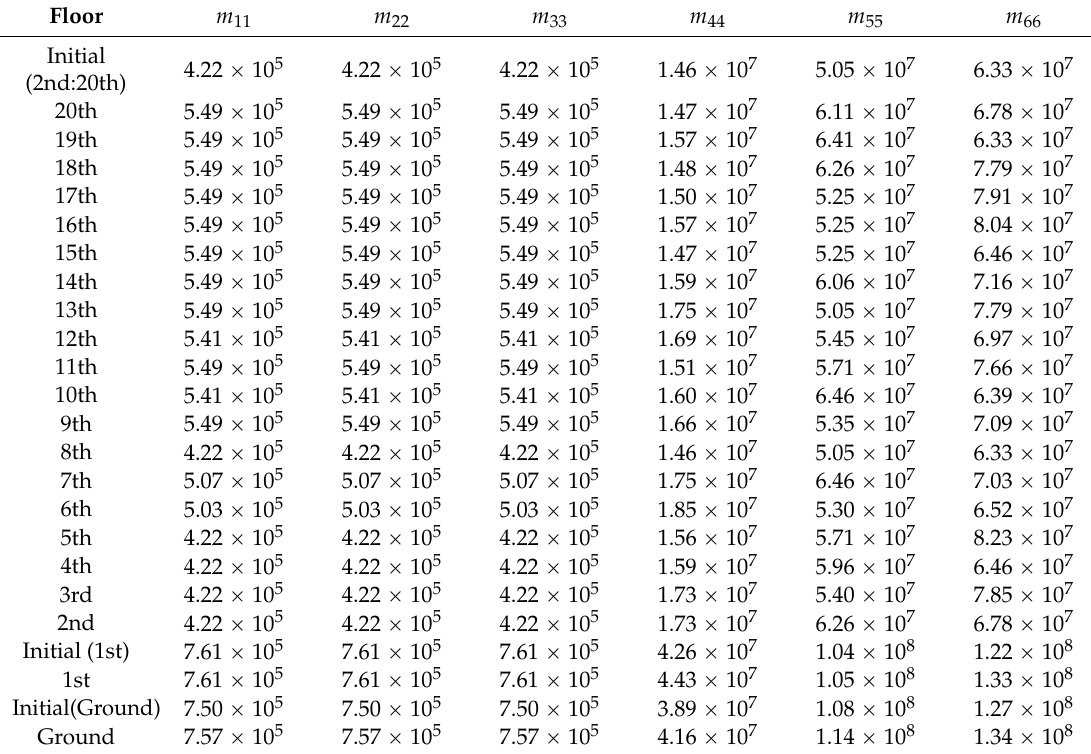
Table 5. Mass and stiffness properties of the Green building: unit